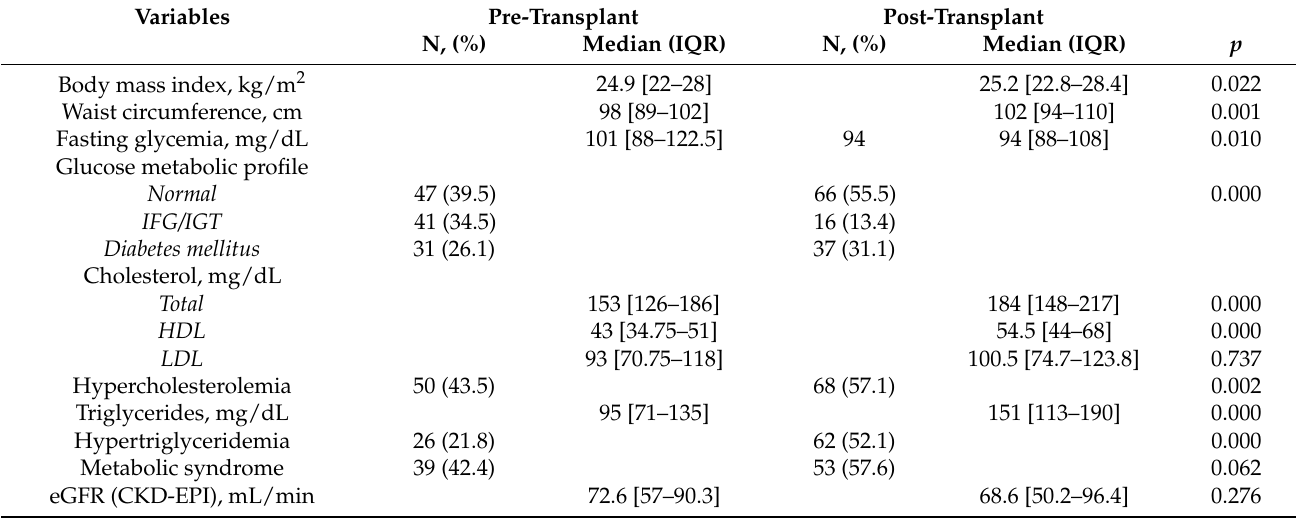
Table 3. Metabolic parameters before and after